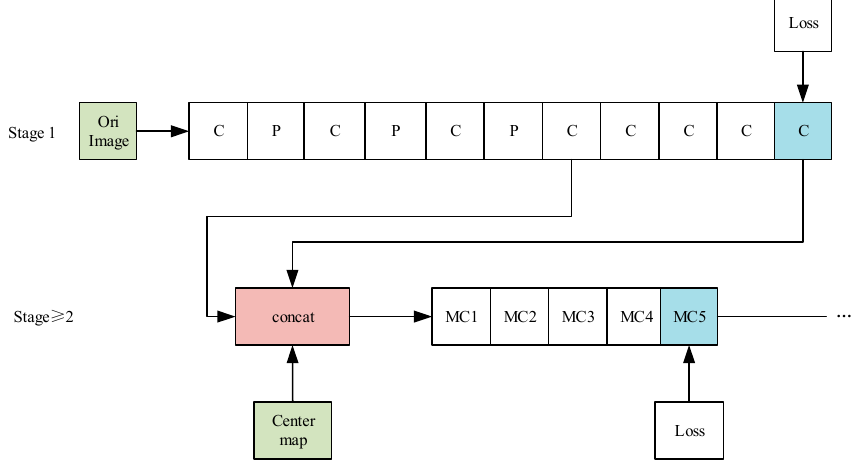
Figure 2. The overall structure of the convolutional pose machines.